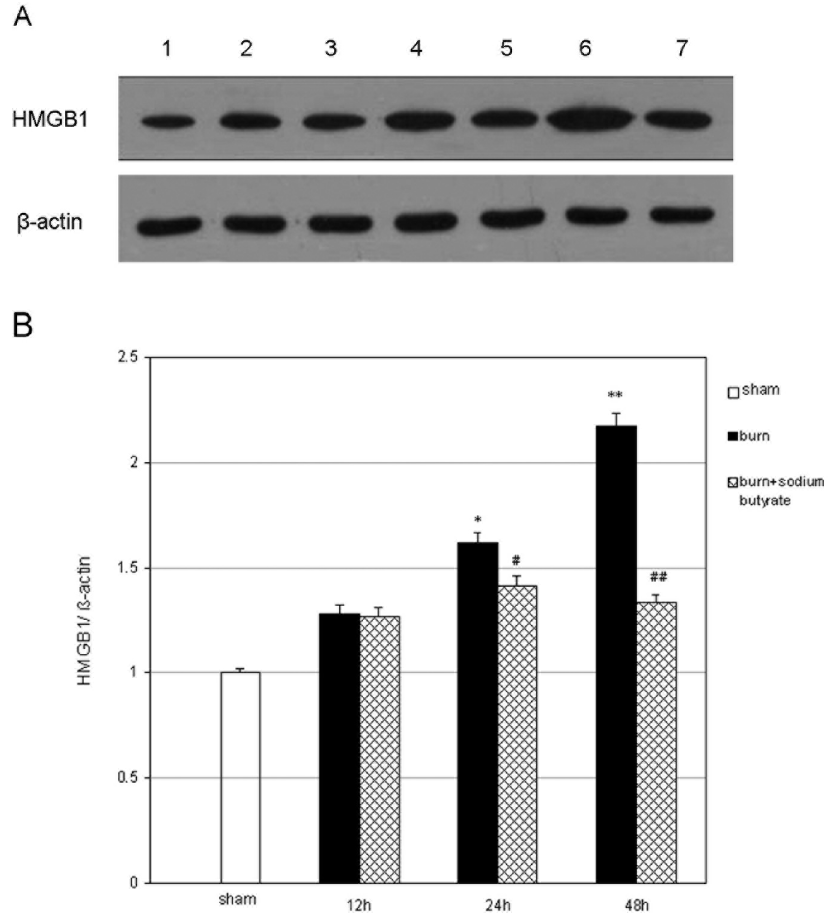
Figure 5. Effect of sodium butyrate on HMGB1 expression in lung tissues. HMGB1 expression in the lungs was evidently increased in the burn group compared with the sham group. Sodium butyrate treatment resulted in a marked decrease in pulmonary HMGB1 expression. (A) A representative results: Lane 1, sham group; Lane 2, burn group at 12 h post burn; Lane 3, burn plus sodium butyrate group at 12 h post burn; Lane 4, burn group at 24 h post burn; Lane 5, burn plus sodium butyrate group at 24 h post burn; Lane 6, burn group at 48 h post burn; Lane 7, burn plus sodium butyrate group at 48 h post burn. (B) Results from the independent experiments and were given as mean 6 SEM (n=8). *p , 0.05, **p , 0.01, vs. sham, ANOVA; # p , 0.05, ## p , 0.01, vs. related burn group,